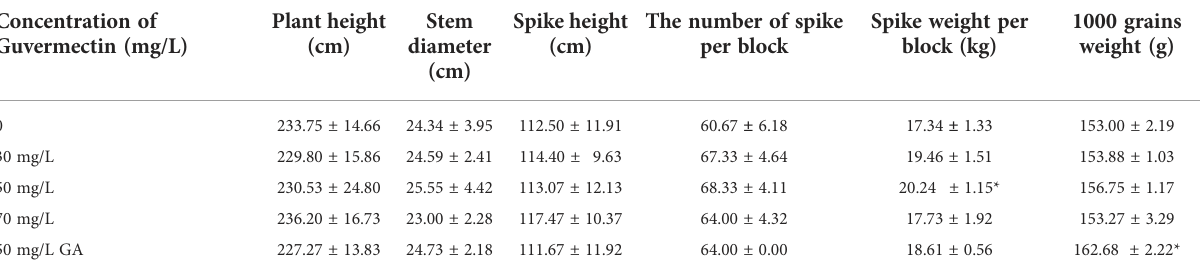
TABLE 3 The effects of guvermectin treatment on the maize seedlings growth in fi eld condition at maturity stage. Concentration of Guvermectin